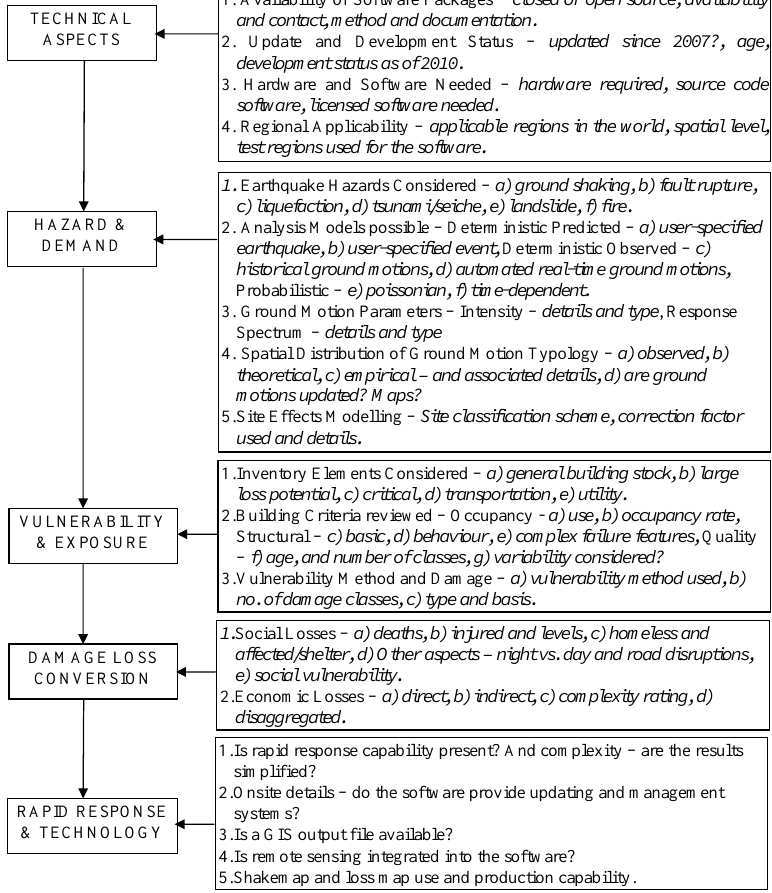
Fig. 5. The components contributing to the MCA Decision Figure 5. The Components contributing to the MCA Decision Tool